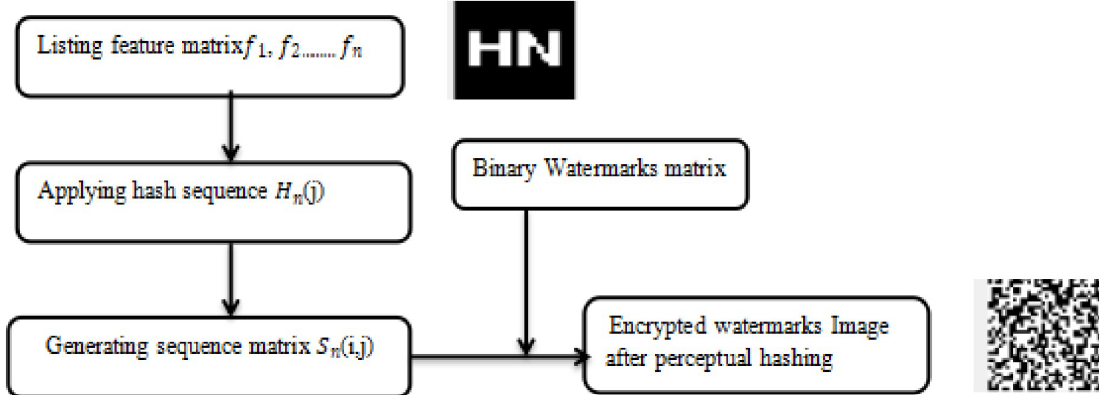
Fig 6. Feature matrix implemented by a hash sequence function.